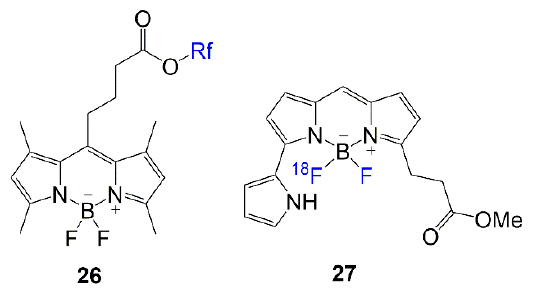
Figure 4. Fluorinated BODIPYs used in 18 FMRI and PET imaging modalities